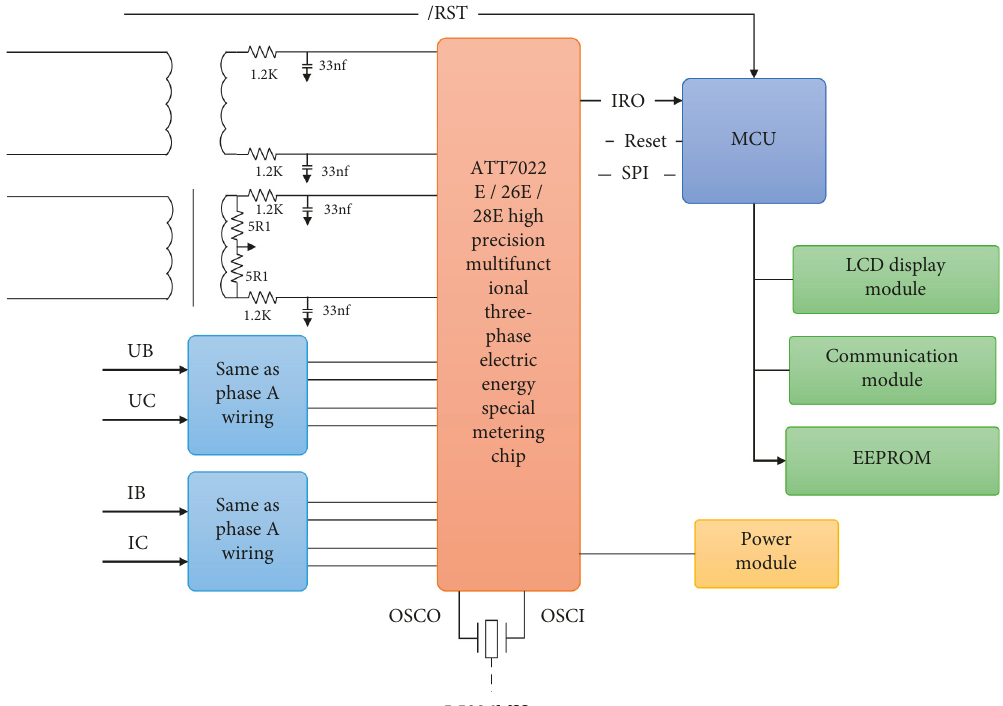
Figure 8: Online behavior collection